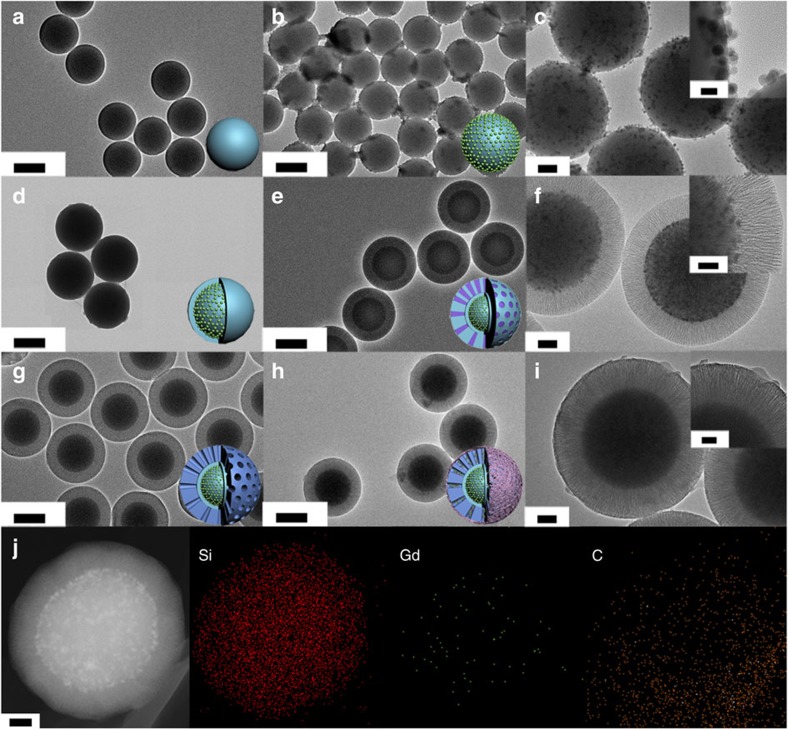
Structural characterization of the as-synthesized microcarriers.(a–i) TEM images of solid SiO2 particles (a), SiO2-Nd (b,c), SiO2-Nd@SiO2 (d), SiO2-Nd@SiO2@mSiO2 (e,f), SiO2-Nd@SiO2@mSiO2-NH2 (g) and SiO2-Nd@SiO2@mSiO2-NH2@SSPI (h,i). Inset images in c,f,i are the corresponding HRTEM images. (j) Dark-field STEM image of a single SiO2-Nd@SiO2@mSiO2-NH2@SSPI microcarrier and EDXS element mapping of elements Si, Gd and C in one microcarrier. (a,b,d,e,g,h) Scale bars, 500 nm; (c,f,i,j) scale bars, 100 nm; (c) scale bars, inset image 20 nm; and (f,i) scale bars, in the inset images 50 nm.